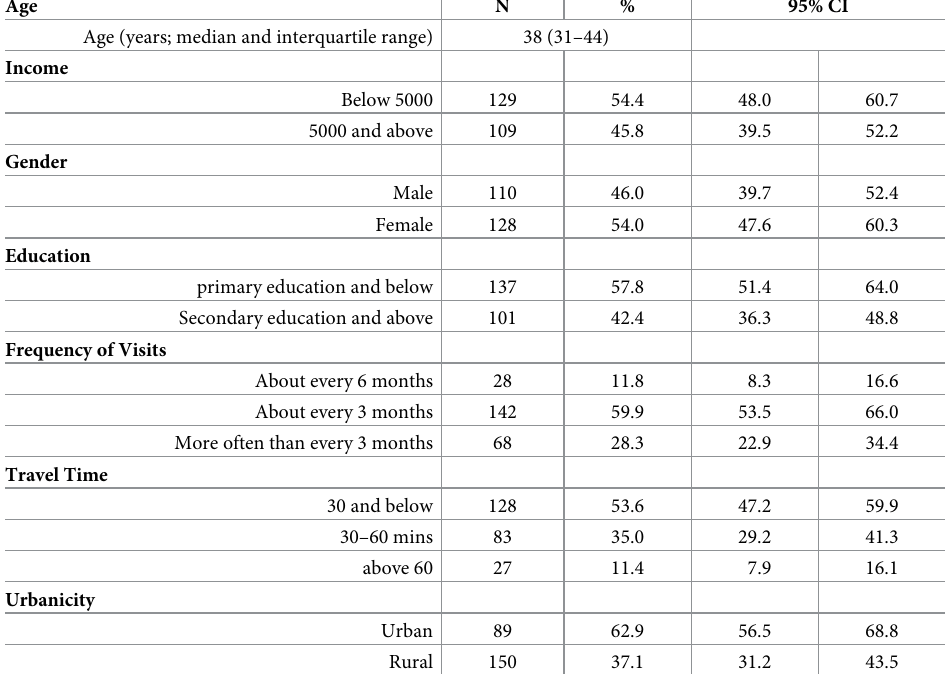
Table 2. Sociodemographic characteristics of respondents.